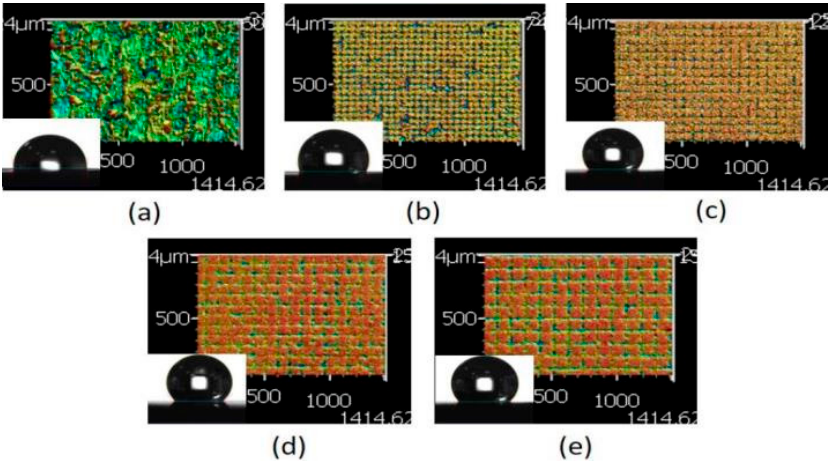
Figure 6. Three dimensional (3D) images of the XO RGP contact lens treated with the laser system with a scanning speed of 500 mm/s and line pitches of ( a ) 30, ( b ) 50, ( c ) 70, ( d ) 90, and ( e ) 110 μ m.